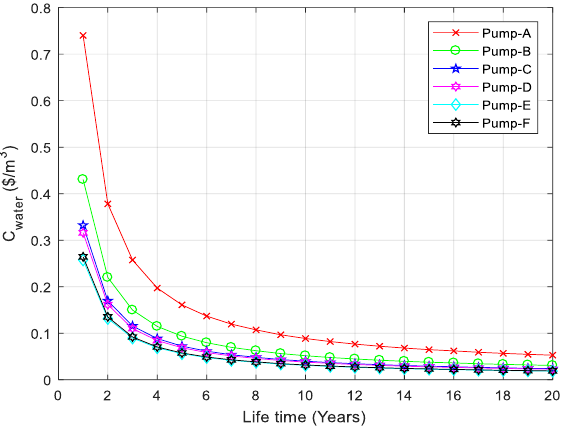
Economic comparison of PV-pump model